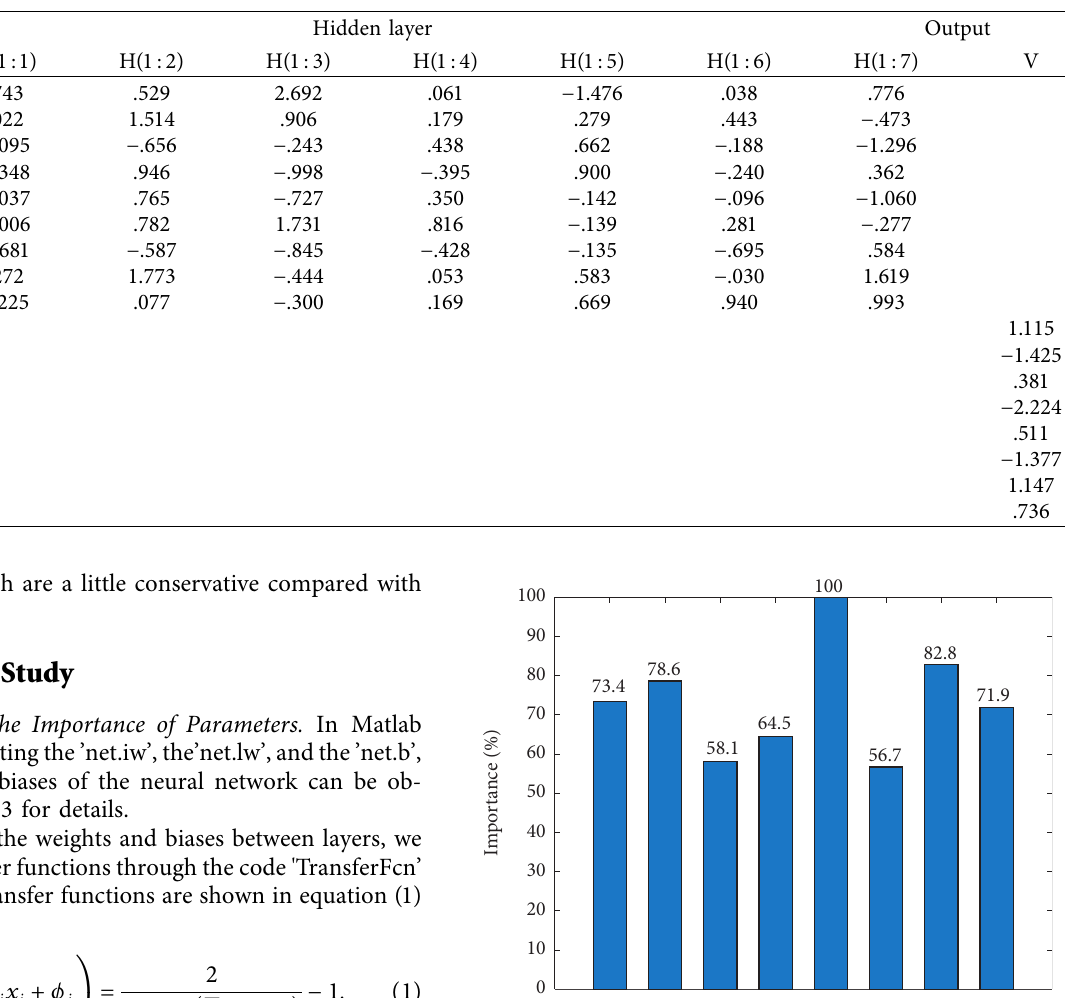
Table 3: Weights and biases between connection layers.